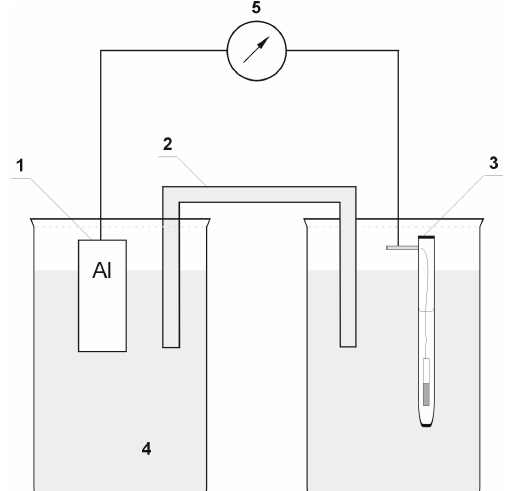
Figure 4. Experimental setup applied in the measurements of electrode potential following hydrogenation (or after the removal of passive layers). 1: sample of alloy, 2: salt bridge, 3: calomel half-cell, 4: electrolyte, 5: multimeter/potentiostat.